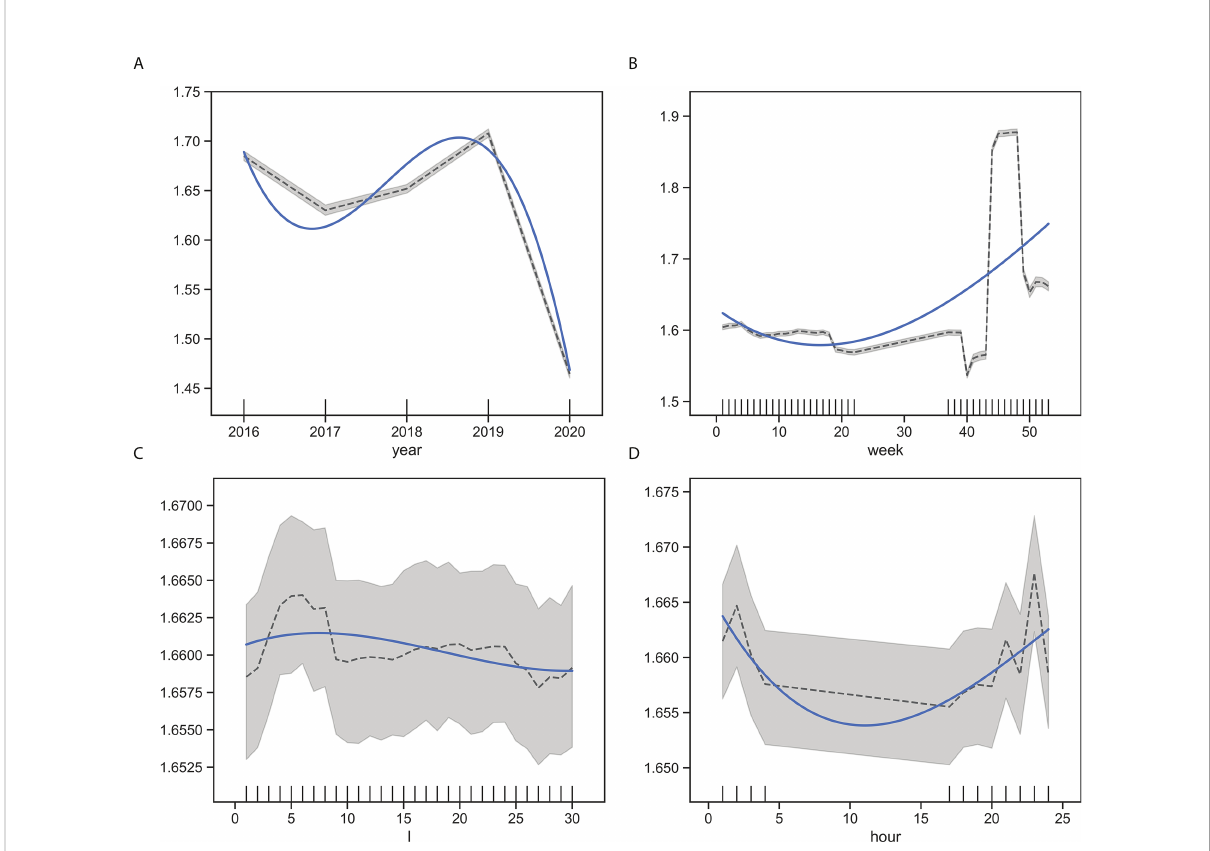
FIGURE 10 Partial correlation diagram of RF model of the in fl uence of time variables on CPUE. (A) year, (B) week, (C) l, (D) hour, the black curve is the in fl uence curve of variable on CPUE, the blue curve is the fi tting of the trend of the in fl uence curve, and the gray area is the 95% con fi dence